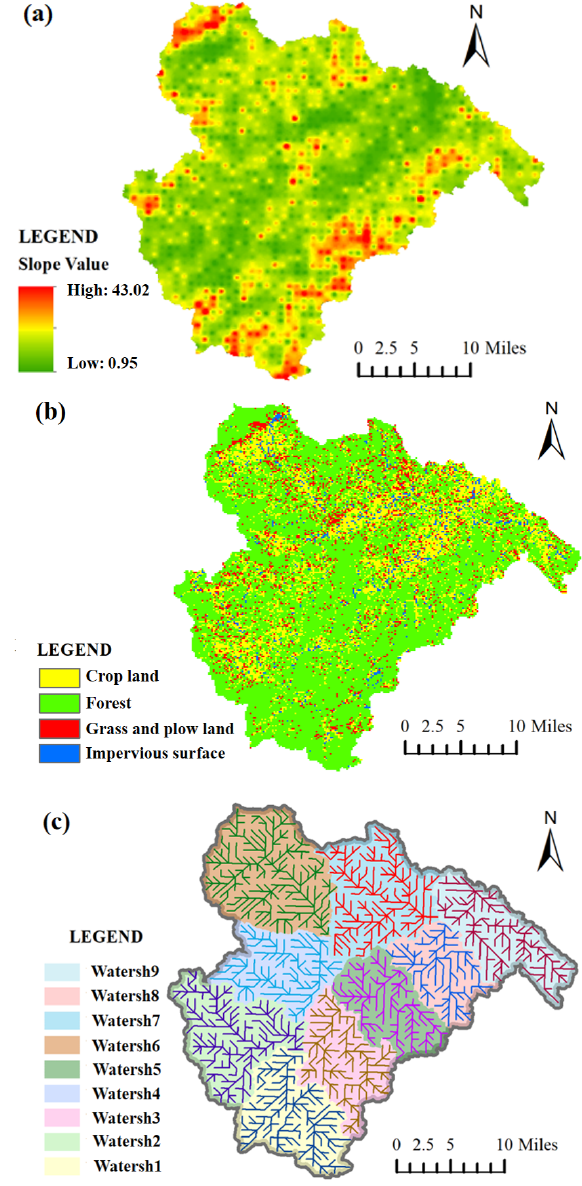
Figure 8. (a) Slope distribution, (b) land types and (c) rasterized flow direction of the Qin River